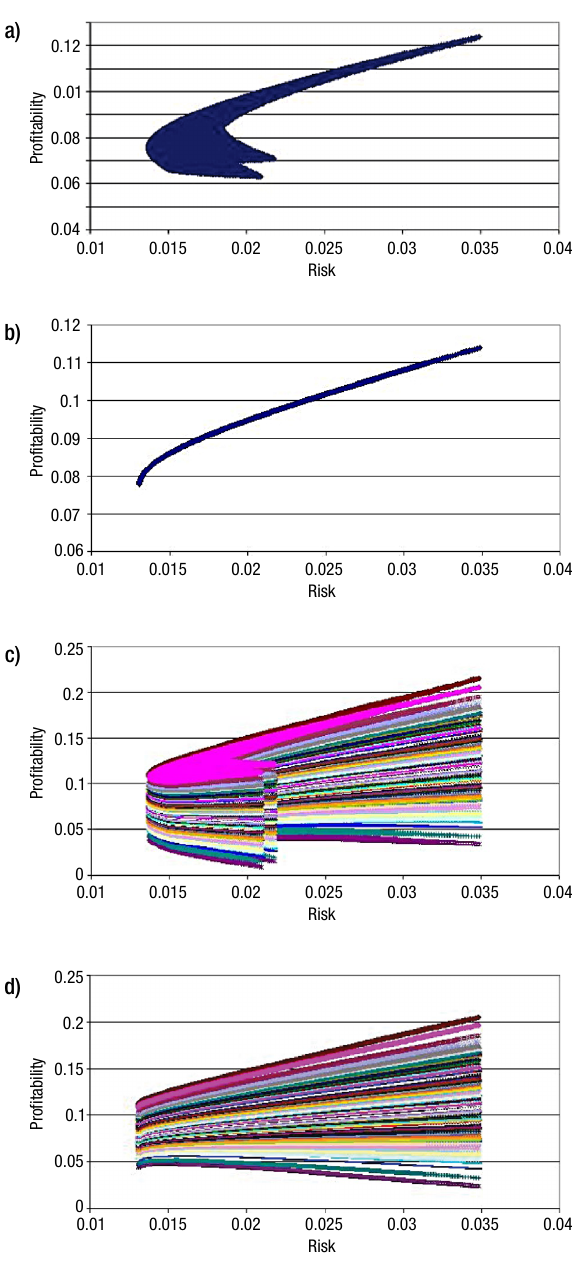
Fig. 1. Initial steps of transition from Markowitz to adequate